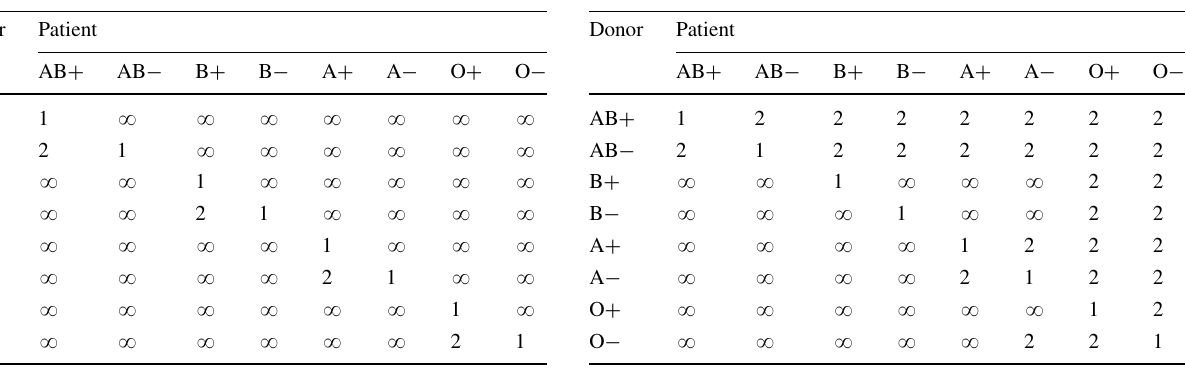
Table 6 Possible ABO/ Rh (D)-compatible substitutions for whole blood. Source Oneblood